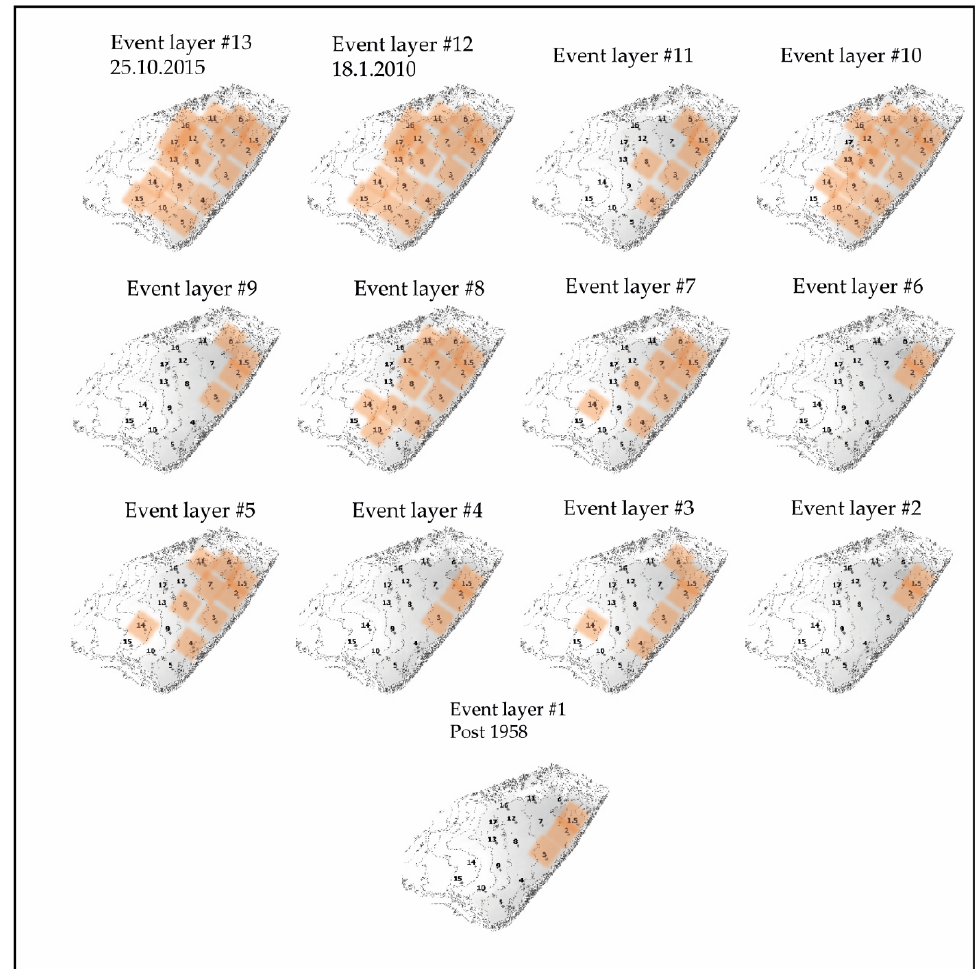
Figure 6. Spatial layout of identified (highlighted in orange) event layers located in each of the pits, in accordance with the correlation shown in Figure 5.